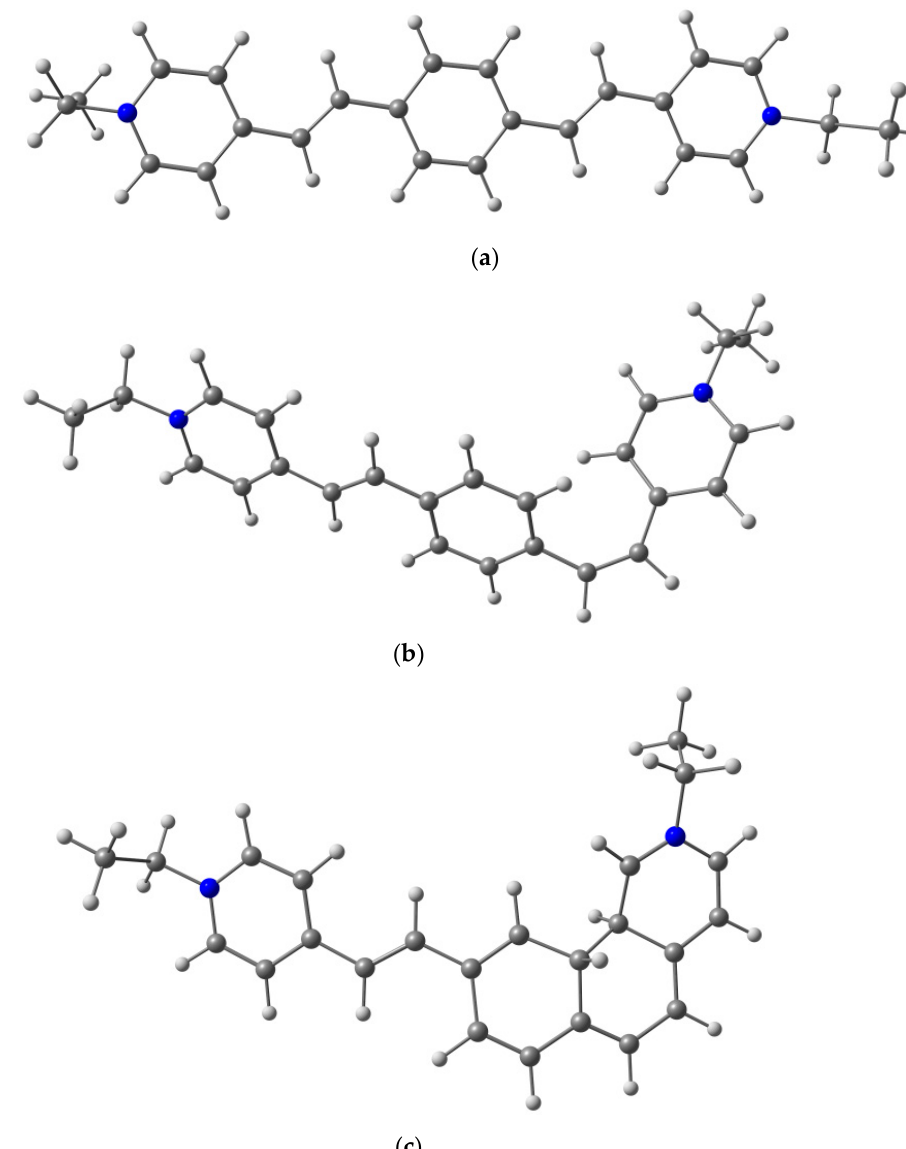
Figure 9. Structures of ( a ) trans- 1 and ( b ) cis- 1 and ( c ) its electrocyclization product dihydrophenanthrene DHP - 1 .